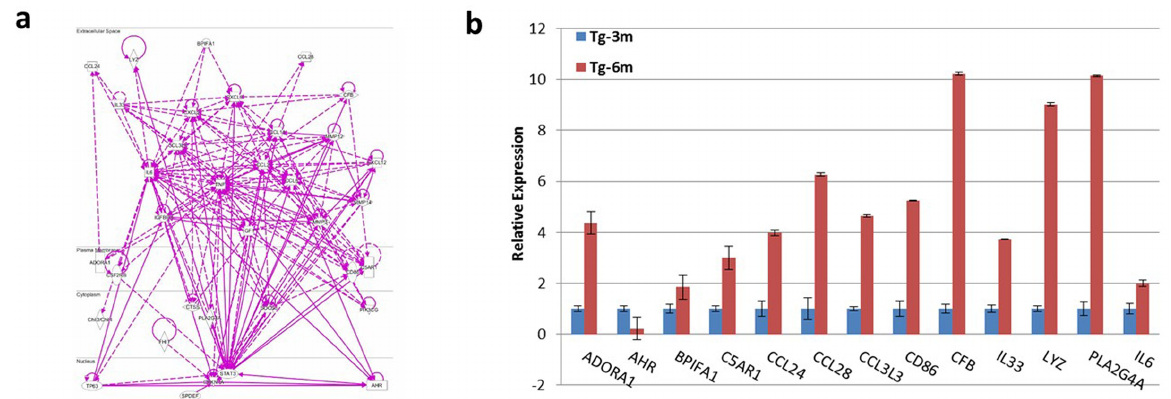
Fig 6. Candidate genes associatedwith the epithelial-mesenchymal transition (EMT). (a) IPA-analyzed EMT-relevantgenes from 6 months (Tg-6m) lung tumors and their interactivenetwork accordingto cellularlocations.(b) Expression levels of EMT-related genesfrom Tg-3m and Tg-6m tumor cells were examinedusing a real-time qPCR. Data shown were representative of 3 independent experiment.